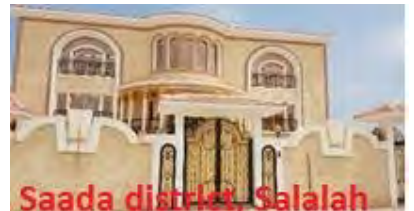
Figure 19. Fac¸ade’s photograph building location